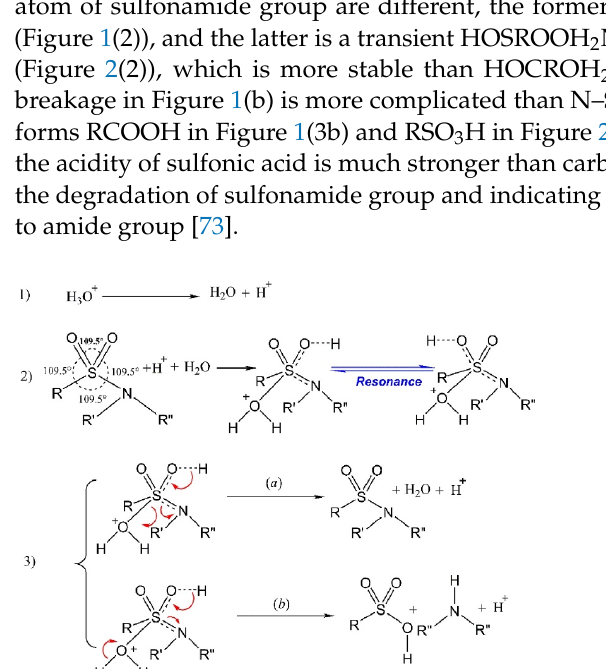
Figure 2. Mechanism of the acid catalyzed hydrolysis of sulfonamides [73].